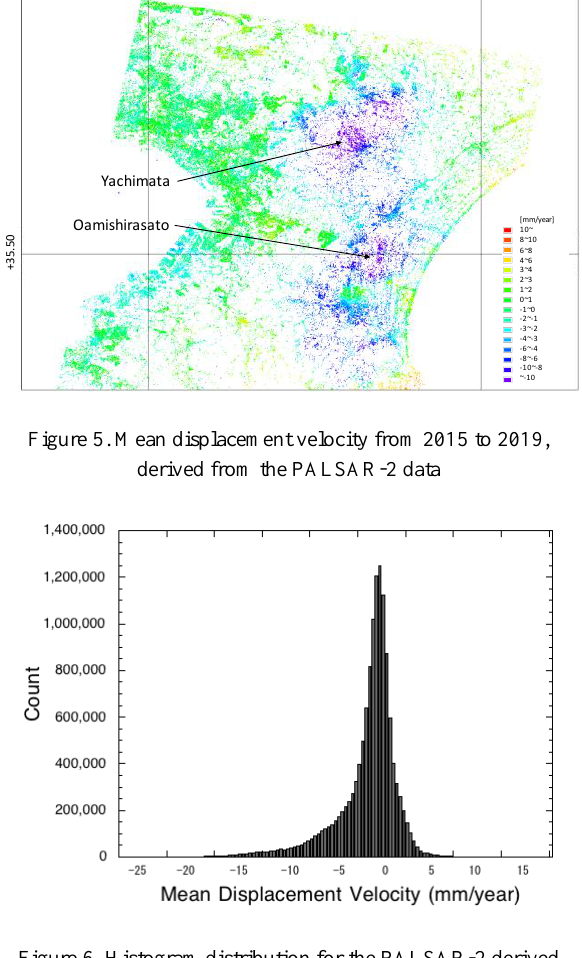
Figure 6. Histogram distribution for the PALSAR-2 derived displacement velocity rates from 2015 to 2019